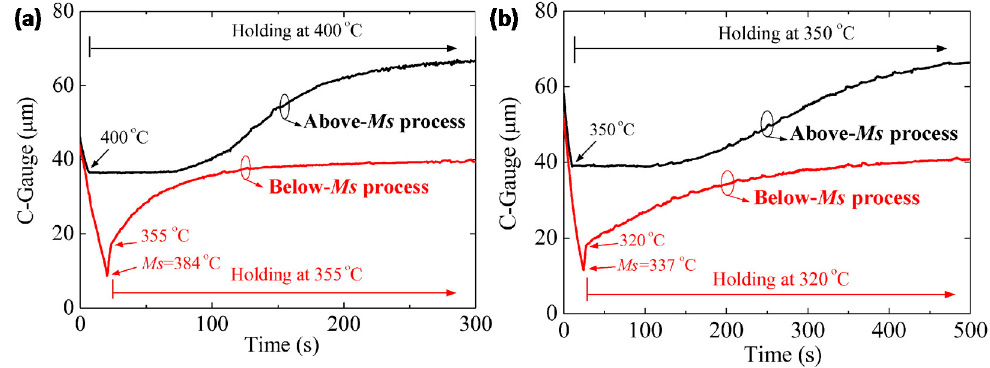
Figure 5. Dilation–time curves of 0.15 C wt. % steel ( a ), and 0.28 C wt. % steel ( b ) during cooling according to the above- and below- Ms austempering processes. Extracted from reference [26]. Reproduced with permission from Elsevier, 2017.